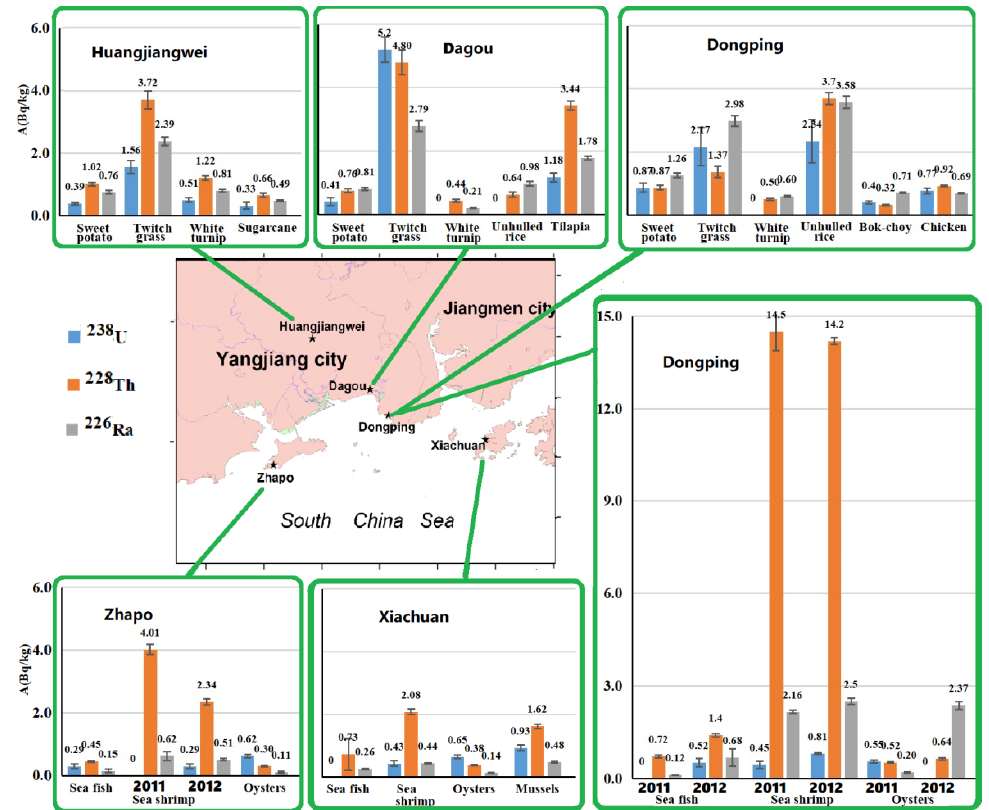
Figure 2. 238 U, 228 Th and 226 Ra in the organisms collected from Yangjiang and the adjacent areas.